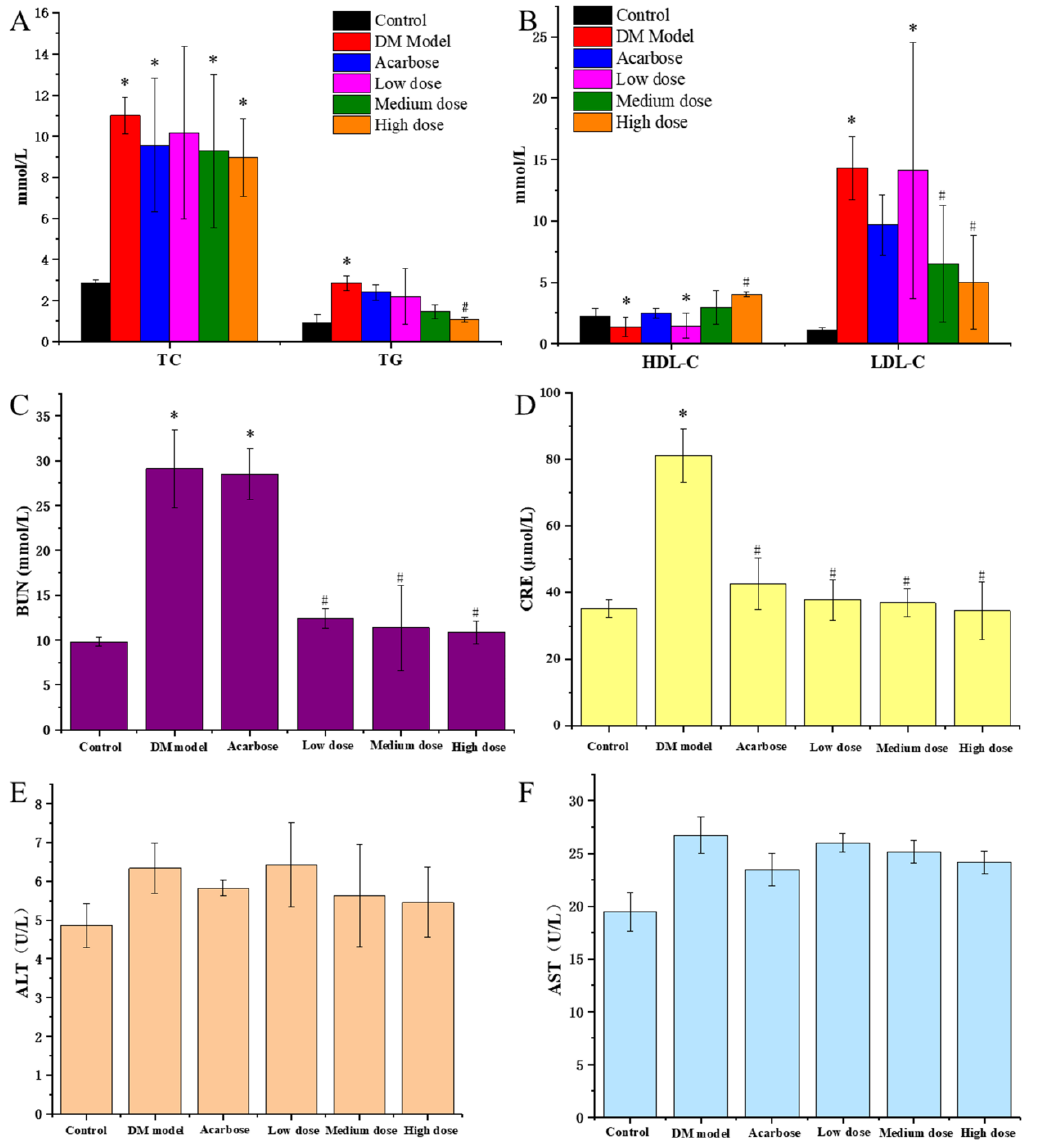
Figure 4. TC and TG ( A ), HDL-C and LDL-C ( B ), BUN ( C ), CRE ( D ), ALT ( E ) and AST ( F ) of the normal rats, untreated diabetic rats and diabetic rats treated by acarbose or DC-5 at different doses for 30 days. All the indicators were detected on the 30th day of the gavage experiment. Where * indicates p ≤ 0.05 when compared with control group; # indicates p ≤ 0.05 when compared with model group.